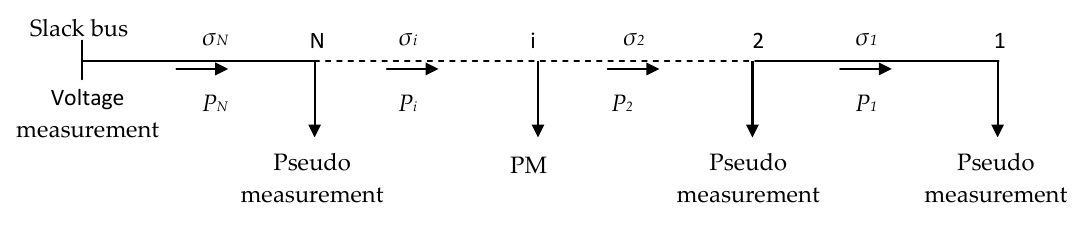
Figure 2. Simple radial Figure 2 . Simple radial feeder.